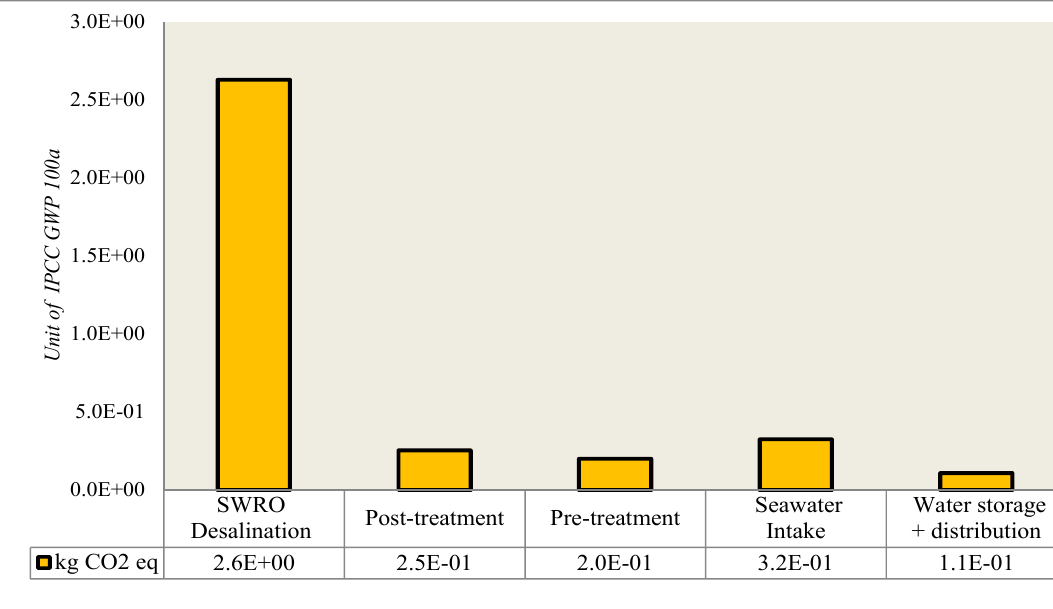
Figure 2. GHG emissions for the Senok SWRO desalination construction stage.